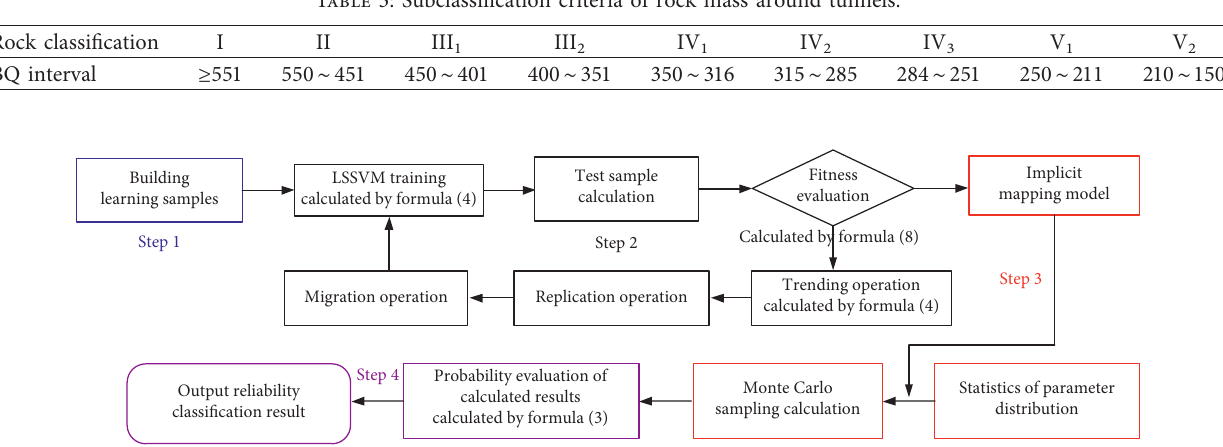
Figure 4: Calculation flow